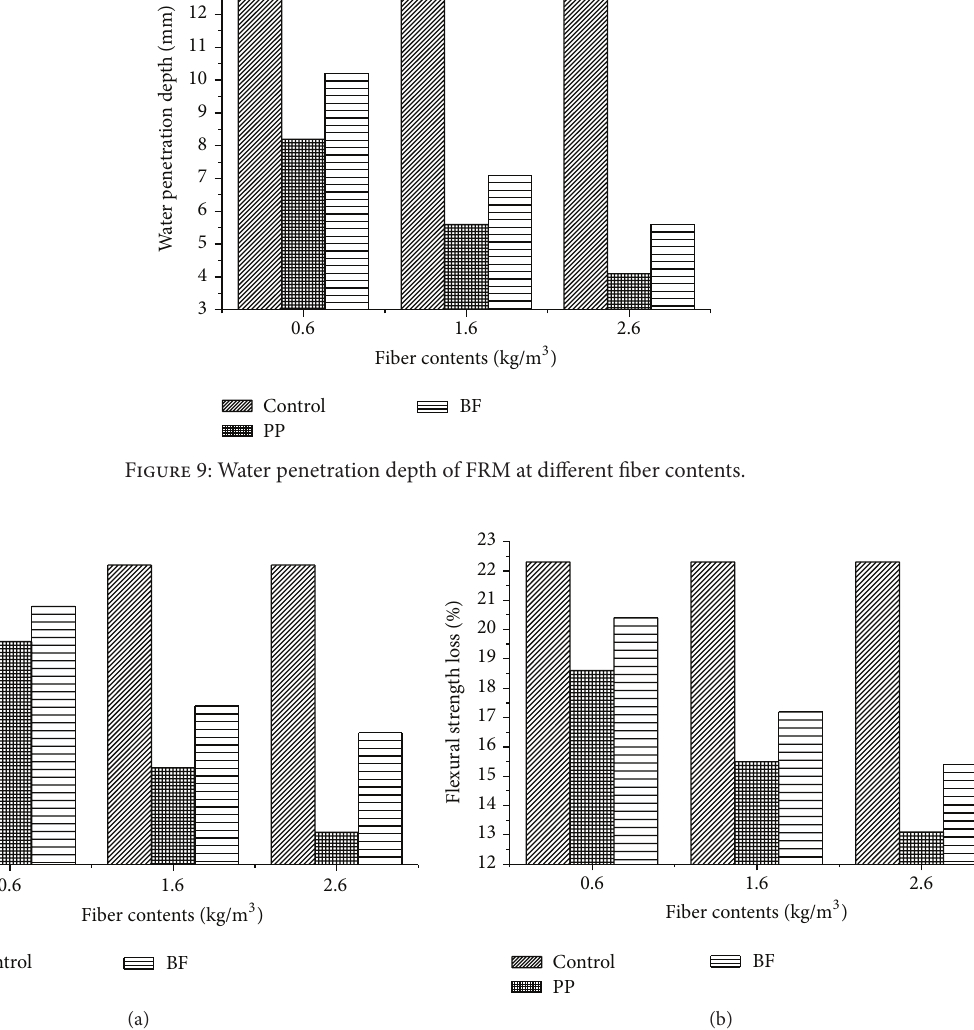
Figure 10: Strength loss of FRM at different fiber contents after 150 cycles of freezing-thawing: (a) compressive strength loss; (b) flexural strength